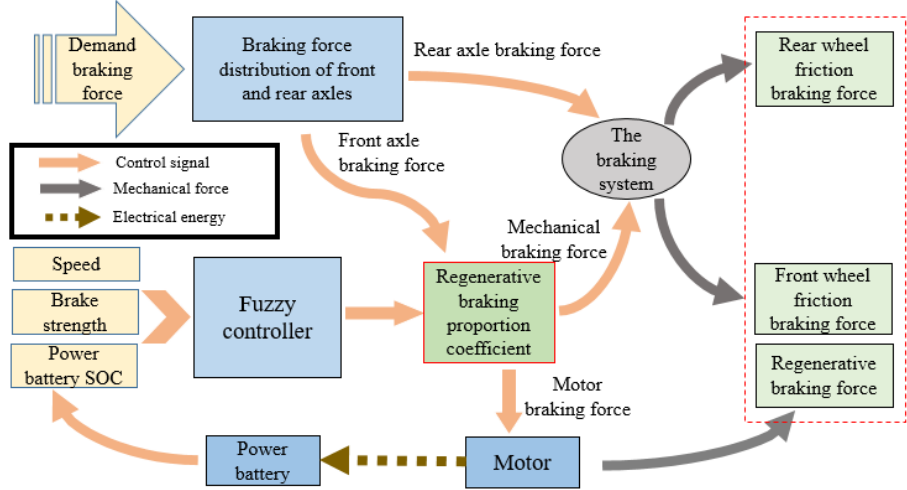
Figure 8. Electromechanical braking force distribution fuzzy control structure.